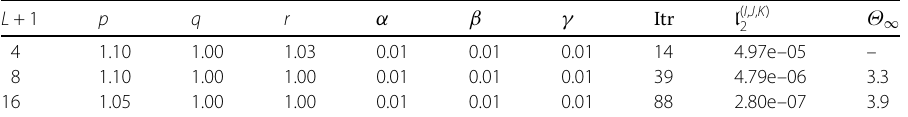
Table 4b Errors and computational rate for the EEG-TOCS in Example 5.4